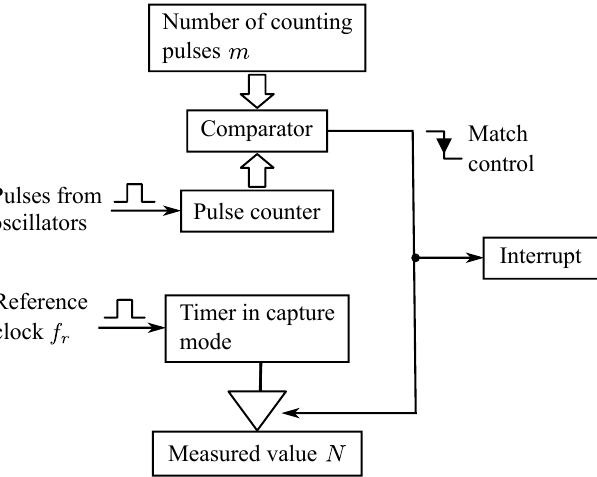
Figure 6. Measurement method by using comparison and